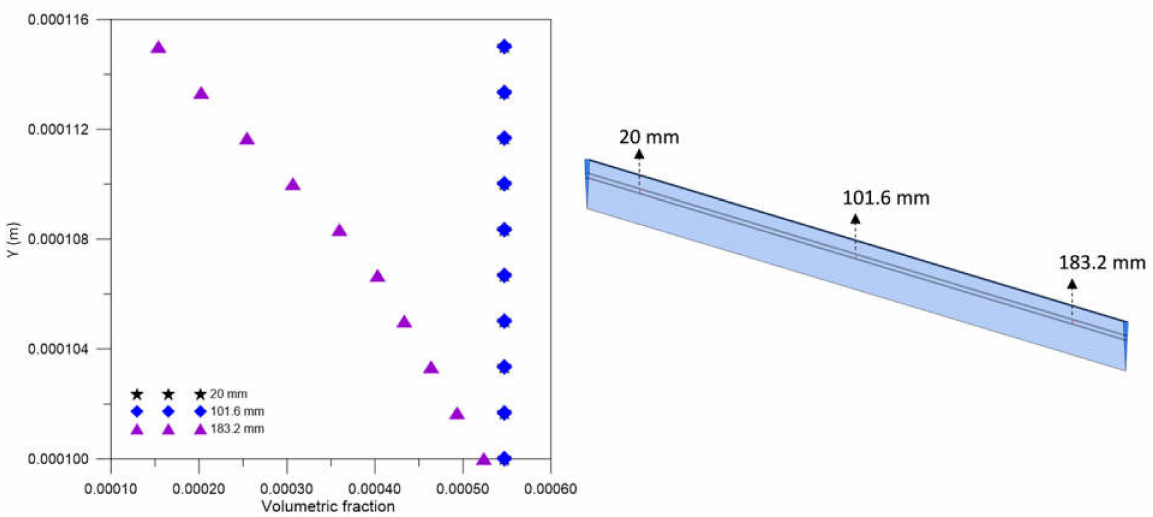
Figure 13. Volume fraction profile of urea inside the membrane, in the axial positions of 20 mm, 101.6 mm, and 183.2 mm, at t = 6200 s (Case 9).